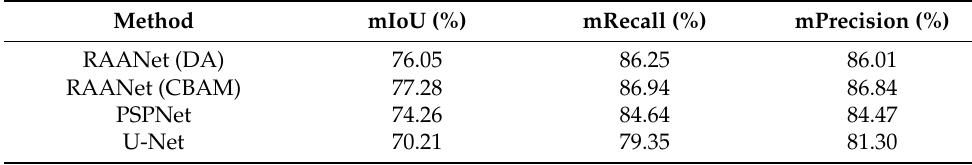
Table 7. Indicator values of different semantic segmentation models.